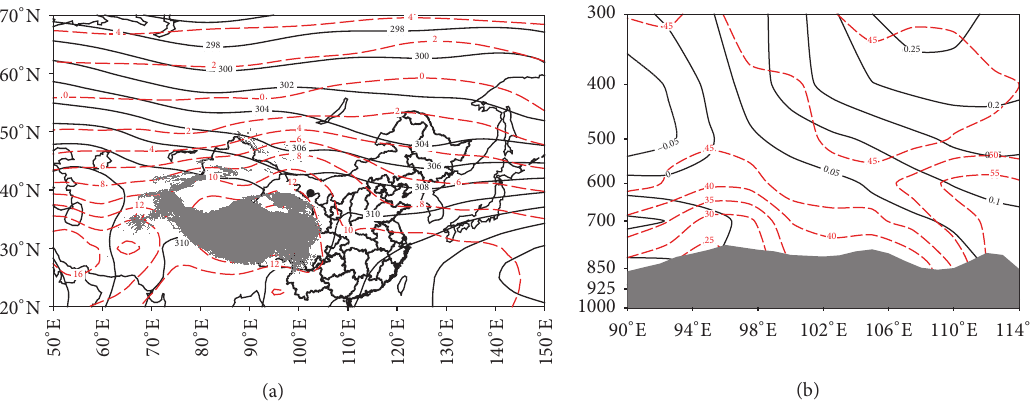
Figure 1: (a) 700 hPa mean atmospheric circulation field during the last 40 years (solid line: geopotential height, unit: gpm; dash line: temperature, and unit: Celsius degree) and (b) mean vertical velocity and relative humidity during the last 40 years along 40 ∘ N (solid line: vertical velocity, unit: cm ⋅ s −1 ; dash line: relative humidity, unit: